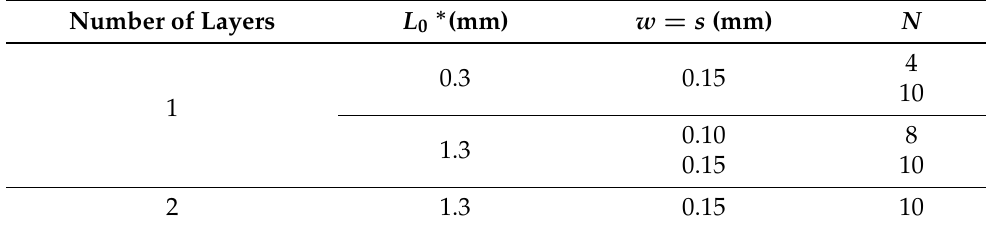
Table 4. Summary of the different simulation groups.